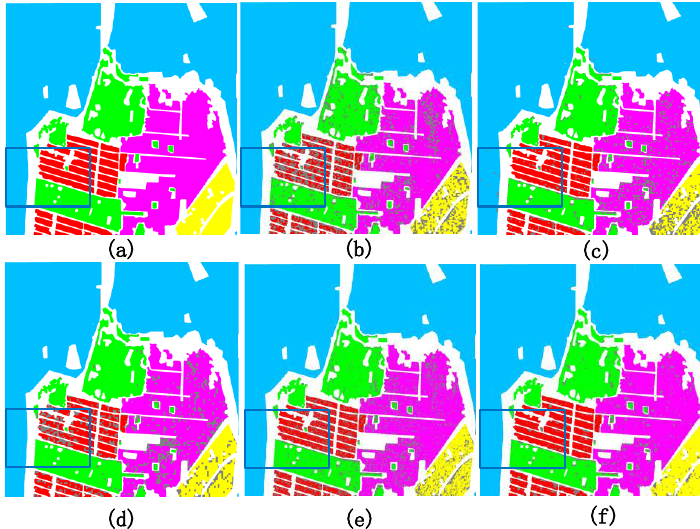
Figure 8. Visual display of classification on San Francisco. ( a ) GT. ( b ) RV-CNN. ( c ) CV-CNN. ( d ) LS-QCNN. ( e ) STS. ( f ) FS-SCNN.